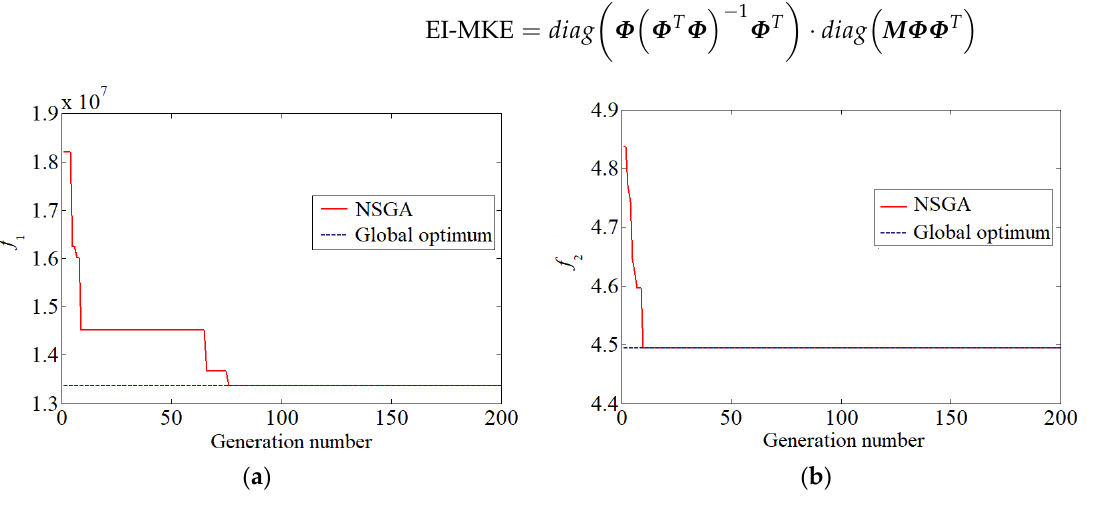
Figure 7. Convergence process of bi-objective optimization: ( a ) f 1 ; ( b ) f 2